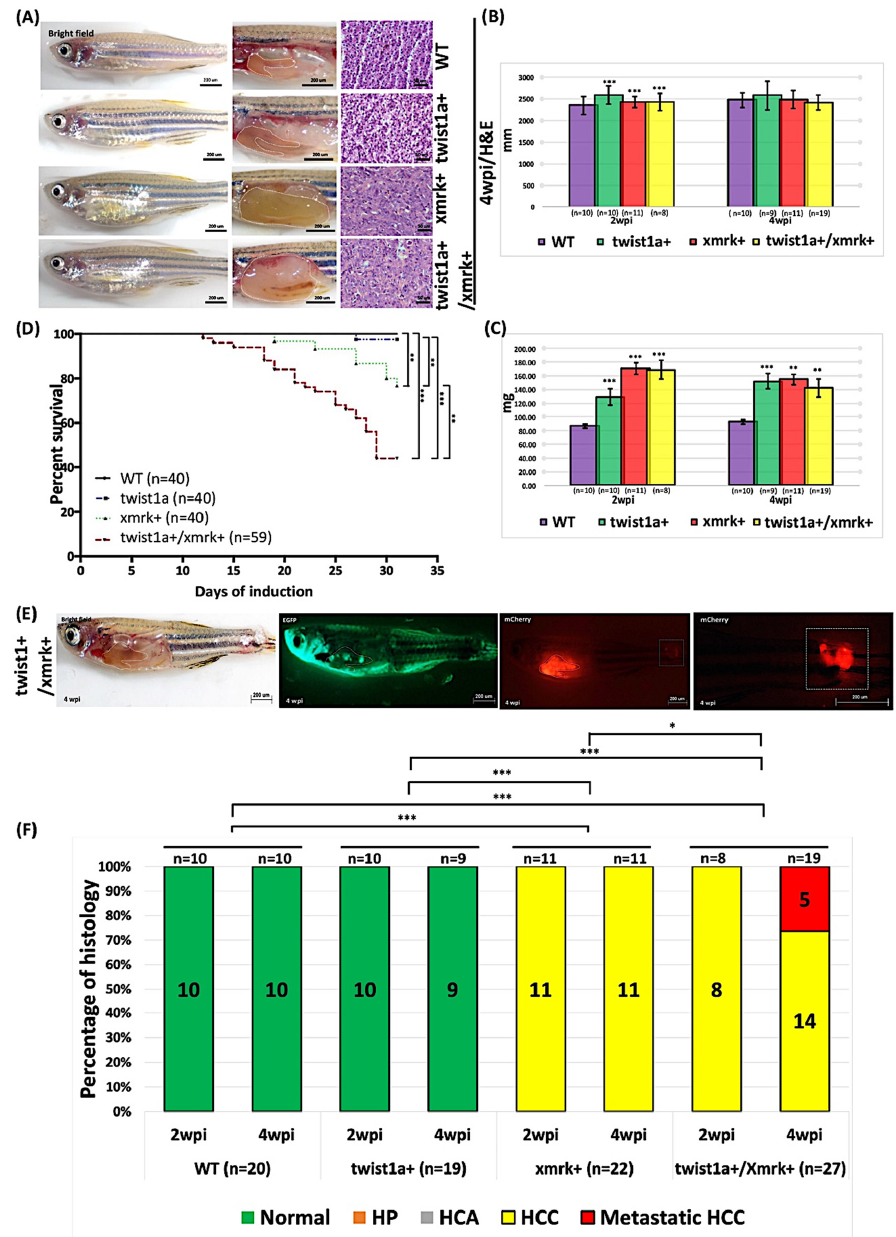
Figure 2. Induction of tumor metastasis in twist1a+ / xmrk+ transgenic zebrafish via treatment with Dox in high concentrations. Twist1a +, xmrk +, and twist1a+ / xmrk+ transgenic zebrafish as well as wild-type control were treated with 60 μ g/mL Dox and 1 μ g/mL 4-OHT starting from 3 mpf. Samples were collected at 2 and 4 wpi. ( A ) Representative images of transgenic zebrafish at 4 wpi. The left column displays external appearance, the middle column shows internal abdominal organs with the livers outlined, and the right column depicts H&E staining of liver sections. Scale bar: 50 or 200 μ m. Compared with the wild-type group, ( B ) the body lengths of transgenic zebrafish differed significantly at 2 wpi but not at 4 wpi, whereas ( C ) the body weights of transgenic zebrafish differed significantly at 2 and 4 wpi. ( D ) Kaplan–Meier survival curves of days post-induction plotted against percent survival to 4 wpi. ( E ) Immunofluorescence analysis of liver tumor metastasis in twist1a +/ xmrk + transgenic zebrafish at 4 wpi. ( F ) Histological examination confirmed that xmrk + and twist1a+ / xmrk+ transgenic zebrafish developed HCC or metastatic HCC at 2 and 4 wpi, whereas normal liver histology was observed in all twist1a + and wild-type siblings. Differences among variables were assessed using Student’s t -tests or one-way ANOVA. Statistical significance: * p < 0.05, ** p < 0.01, *** p <